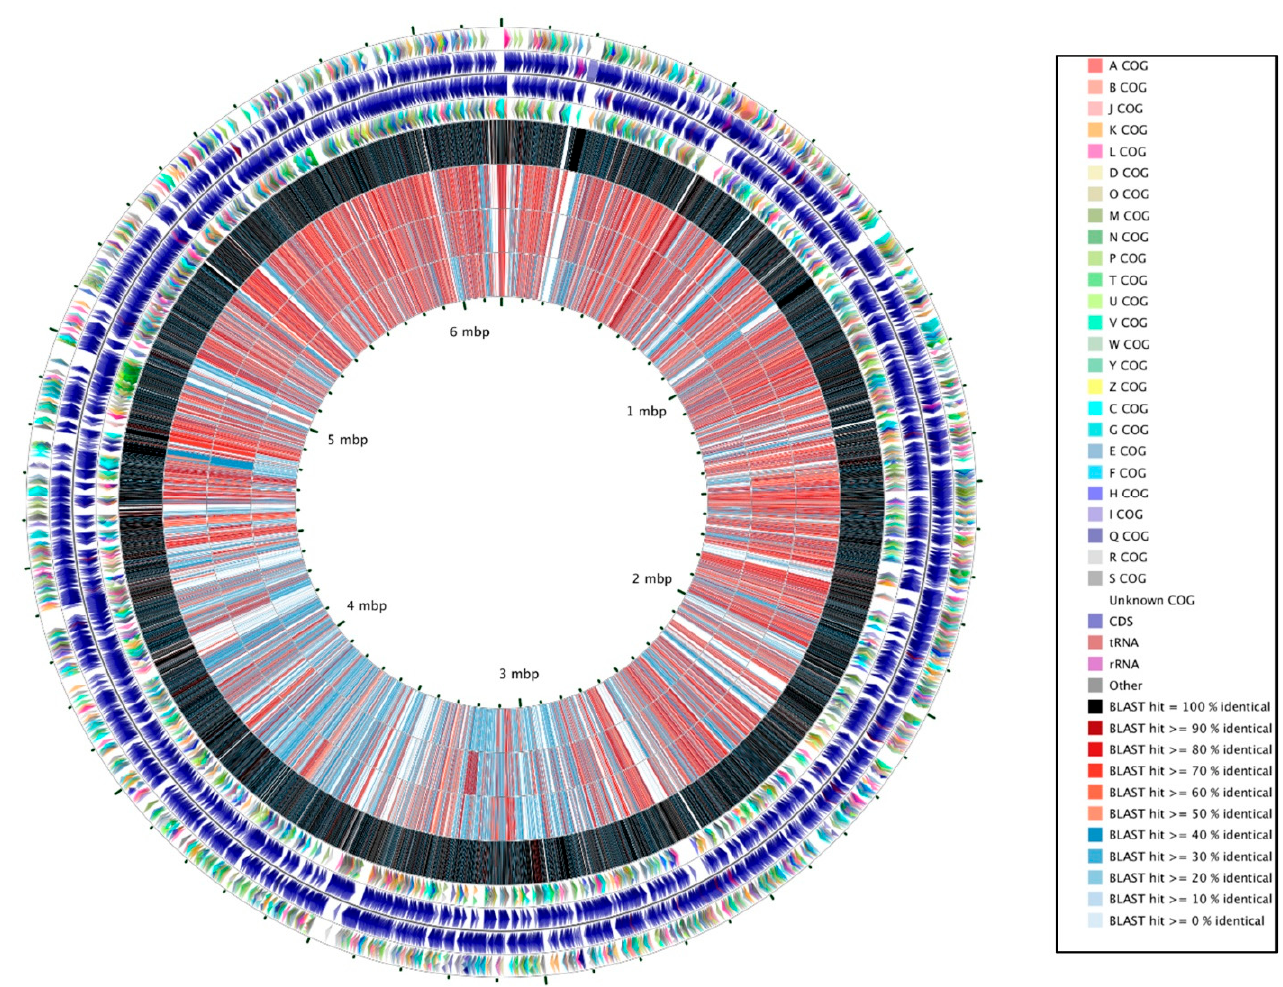
Figure 1. Comparison of three Pseudomonas spp., isolated from oyster tissue (strain OT69), water column (strain WC55) and mantle fluid (strain MF28) relative to Pseudomonas putida KT2440 as the reference strain, using the CGView Comparison Tool [40]. The outermost two rings depict Clusters of Orthologous Gene (COG) functional categories (first ring) and genes (second ring) on the forward strand of Pseudomonas putida KT2440. The third and fourth rings depict COGs and genes, respectively, on the reverse strand. The remaining rings display the results of blastp comparisons between the Pseudomonas putida KT2440 (CDS; coding DNA sequences) translations and the CDS translations from Pseudomonas putida KT2440, Pseudomonas alcaligenes OT69, Pseudomonas aeruginosa WC55, and Pseudomonas stutzeri MF28. For the BLAST comparisons an E-value cutoff of 0.1 was used. The regions of the reference genome yielding blast hits are indicated within each BLAST results ring, and each region is colored according to the percent identity of the hit. Table 1. Pair-wise comparisons of isolated Pseudomonas species with type strains available in the Type (Strain) Genome Server (TYGS)